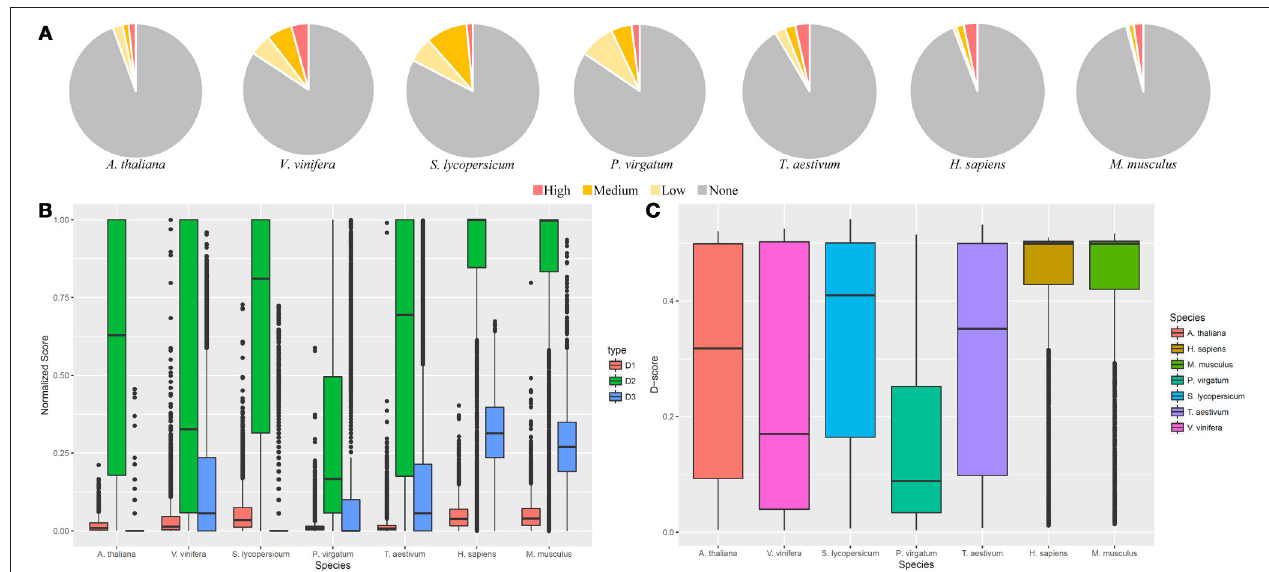
FIGURE 3 | G eneQC application . The results related to the analysis of seven datasets representing five plant and two animal species. (A) Categorizations for the level of mapping uncertainty per gene are shown relative to all categorizations. (B) Boxplots for the three extracted features of each gene are shown for each analyzed sample. D 1 , D 2 , and D 3 represent the sequence similarity, proportion of shared MMR, and degree weight, respectively. Each value is shown normalized between 0 and 1. Only genes with mapping uncertainty are displayed. (C) Derived D-scores for each gene are shown by species, as calculated from the three features in (B). Higher D-scores represent higher levels of mapping